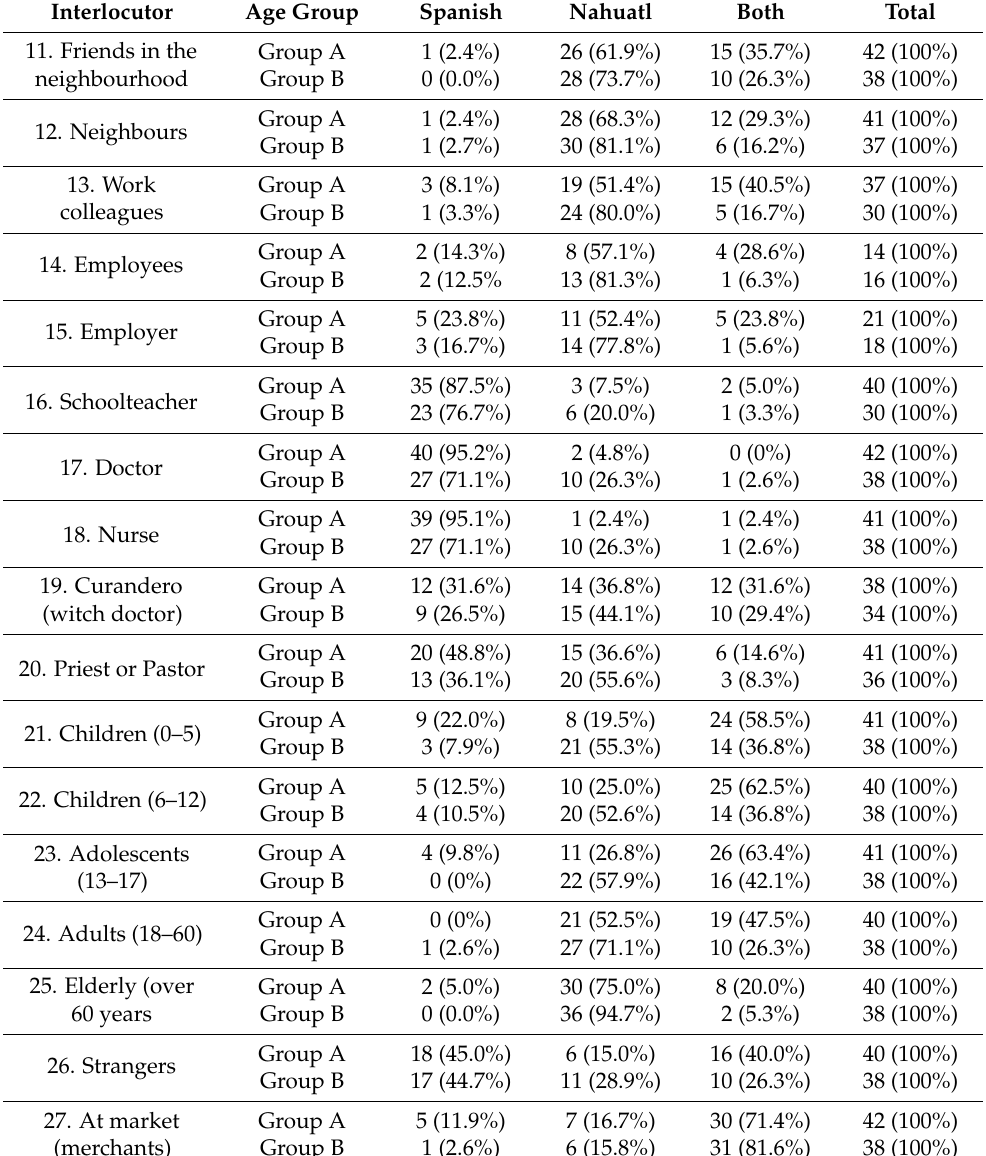
Table 3. Language use in the community by age